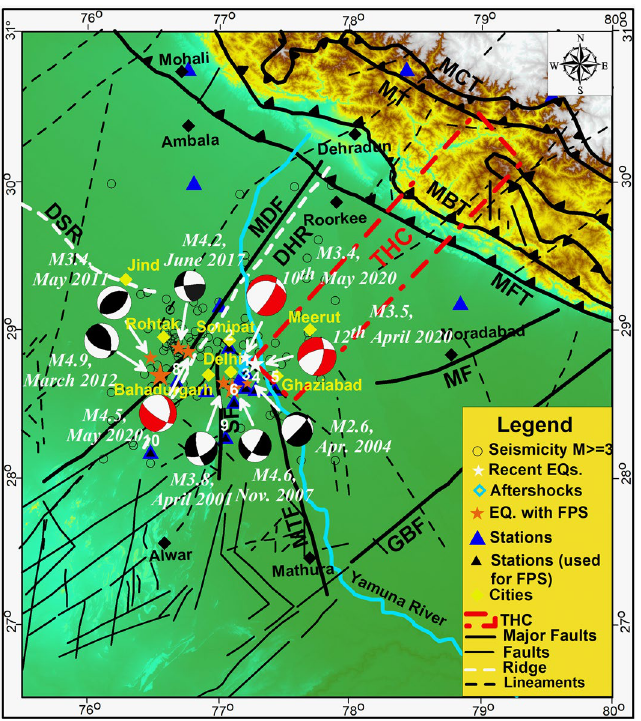
Figure 2. Tectonic map of the Delhi region with the Trans- Himalayan Conductor (THC) superimposed on it. The earthquakes with magnitude M > 3.0 from 2001 to 10th June 2020 are plotted (stars) from the earthquake catalog prepared by NCS, New Delhi. Major tectonic features of the Himalaya; Main Boundary Thrust (MBT), Main Central Thrust (MCT) and Main Frontal Thrust (MFT) are shown along with the regional tectonic features including Mahendragarh–Dehradun Fault (MDF), Delhi–Hardwar Ridge (DHR), Moradabad Fault (MF), Sohna Fault (SF), Mathura Fault (MTF) and Great Boundary Fault (GBF). The fault plane solutions of the four past earthquakes are shown with black & white beach balls prepared from and the recent (12th April 2020, 10th May 2020 and 29th May 2020) earthquakes are shown with red & white beach balls. The stations used for computation of fault plane solutions are shown with black triangles and station numbers (1:NDI; 2:NRLA; 3: LDR; 4:JMIU; 5:BISR; 6:AYAN; 7:UJWA; 8:JHJR; 9:SONA; 10:KUDL). The tectonic features are from the files provided at BHUKOSH portal of Geological Survey of India (http:// bhuko sh. gsi. gov. in/ Bhuko sh/ MapVi ewer. aspx). These features are overlapped on SRTM data of 90 m resolution (http:// srtm. csi. cgiar. org). The figure